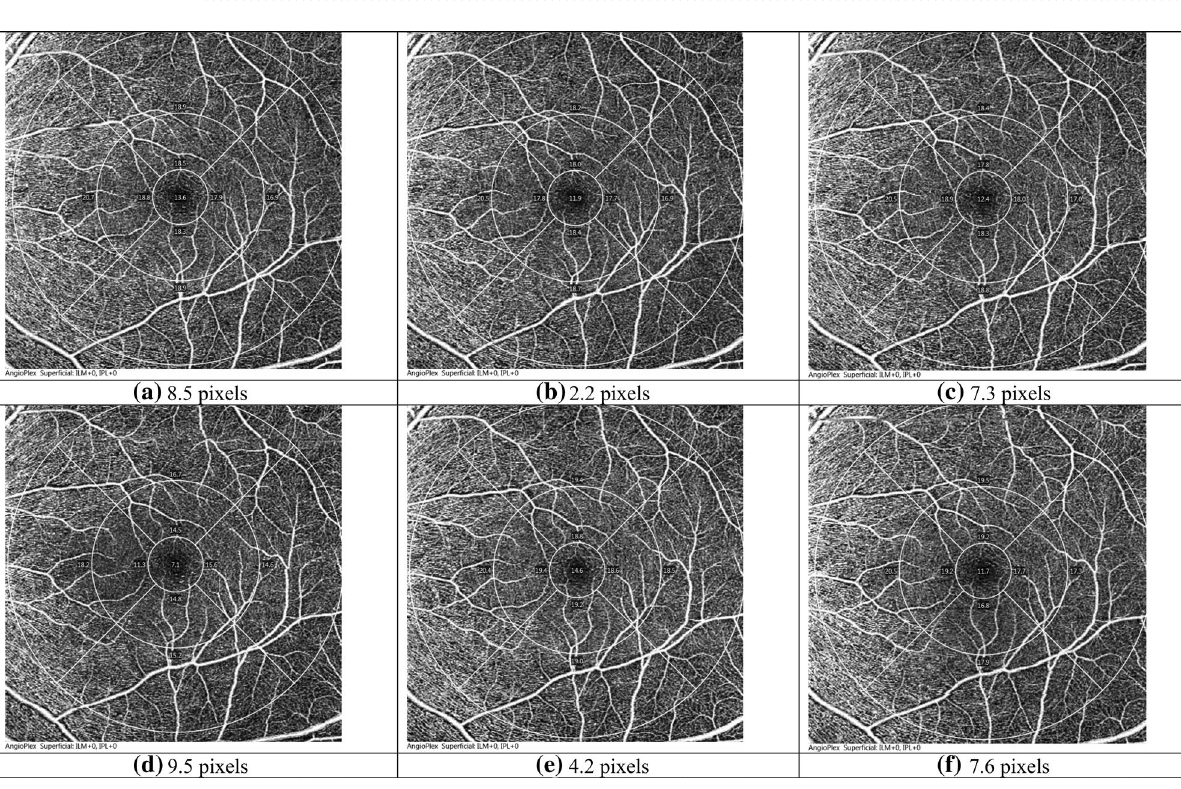
Figure 6. Three OCTA images from subject #027. ( a – c ) Correction with auto-focus (mean FD: 9.1 pixels; TRR: 8.8 pixels); ( d – f ) Correction with contact lens (mean FD: 5.2 pixels; TRR: 3.6 pixels).